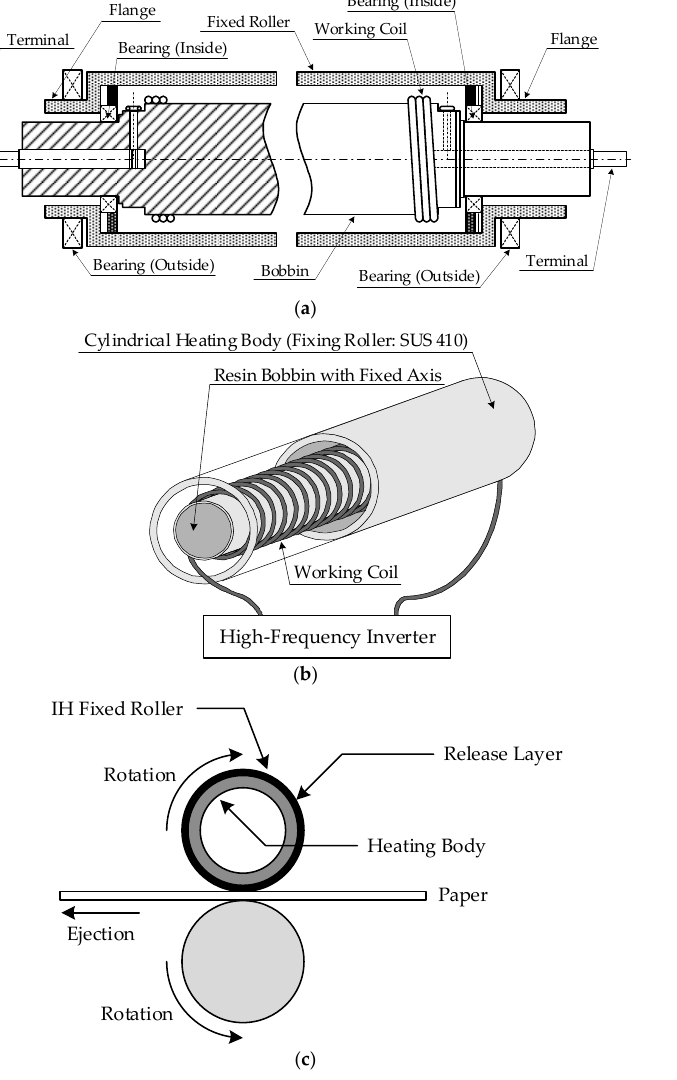
Figure 1. Induction heating fixed roller for copy and printing machines. ( a ) Sectional view. ( b ) Internal configuration. ( c ) Toner fixing process.